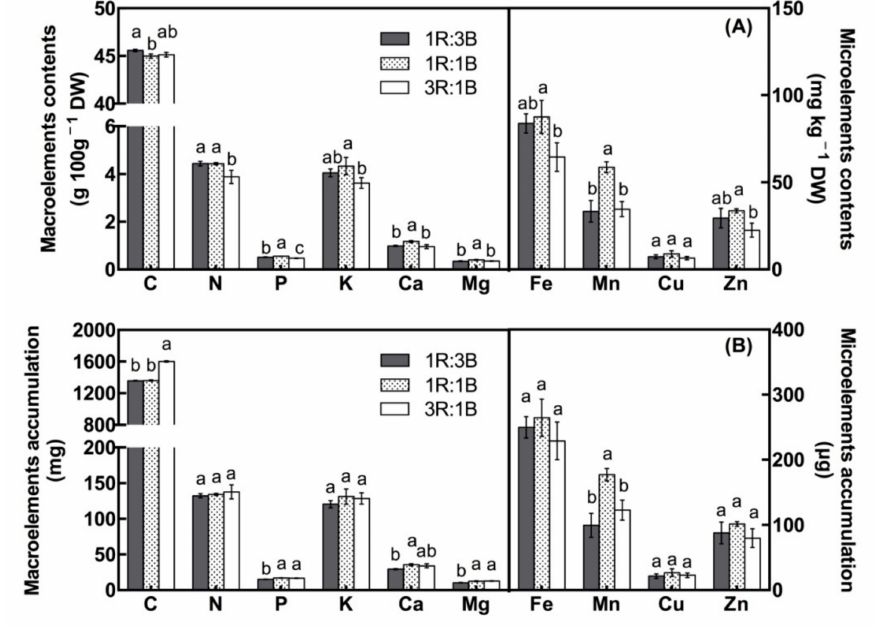
Figure 4. E ff ects of continuous light of di ff erent light qualities on nutrient element contents; ( A ) and accumulation; ( B ) of hydroponic lettuce. Di ff erent letters indicate a significant di ff erence among treatments at p <